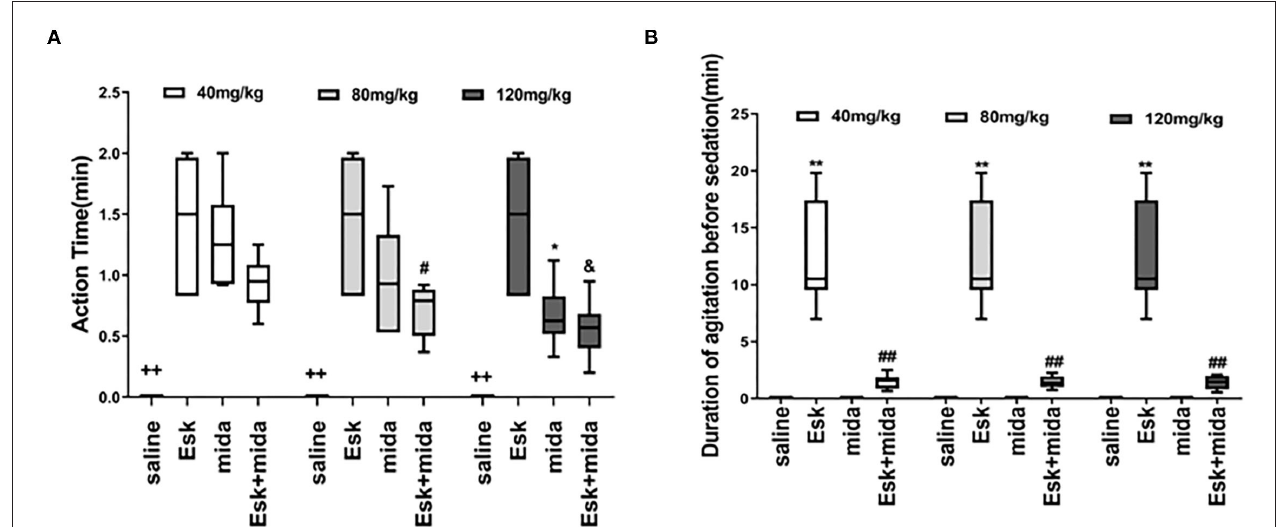
FIGURE 1 | Action time and recovery time. (A) Action time ++ P < 0.01, compared to Esk, Mida, and Esk + Mida groups. # P < 0.05, compared to Esk group. * P < 0.05, compared to Esk group. & P < 0.05, compared to Esk group. (B) Duration of agitation before the sedation. ** P < 0.01, compared to Saline, Mida, and Mida + Esk groups. ## P < 0.01, compared to Saline and Mida